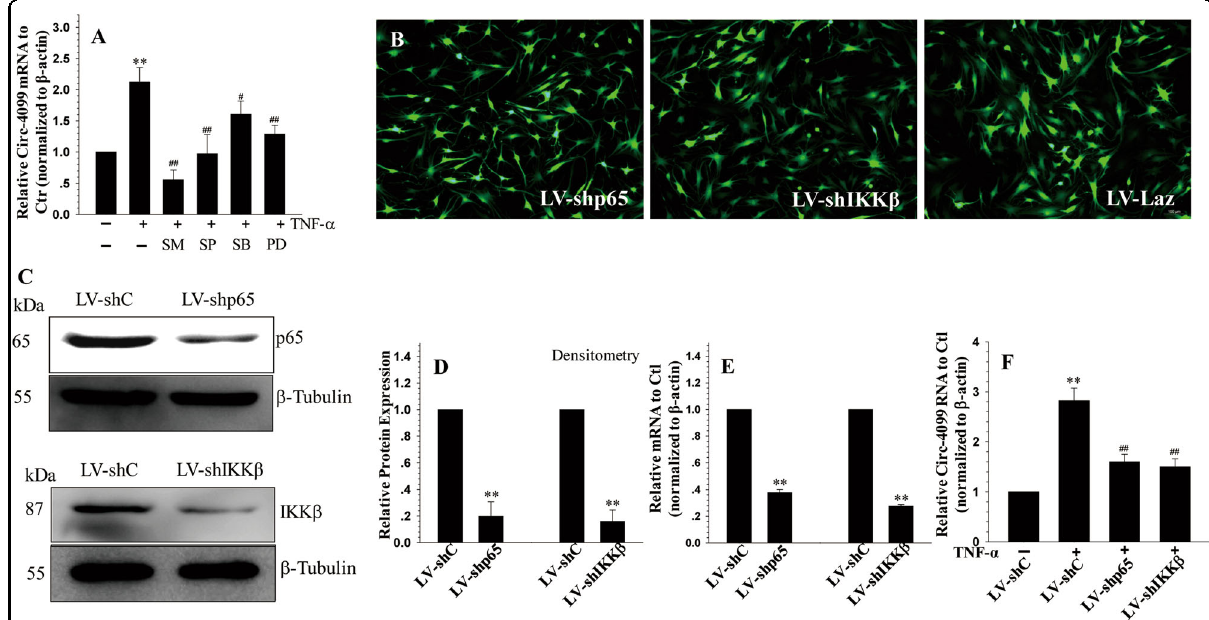
Fig. 2 MAPK and NF- κ B regulation of circ-4099 expression. a qRT-PCR analysis shows that the TNF- α -dependent induction of circ-4099 in NP cells is blocked by MAPK and NF-kB pathway inhibitors. b Immuno fl uorescence detection of GFP in human NP cells transduced with lentivirus (LV) co- expressing GFP and either sh-p65 or sh-Ikk β showed high transduction ef fi ciency. c Western blot, d corresponding densitometry, and e RT-PCR analyses of cells transduced with LV-shLaz, LV-shp65, and LV-shIkk β . Expression of p65 and Ikk β is signi fi cantly blocked by the respective shRNAs compared with the control. f qRT-PCR analysis of circ-4099 expression in cells infected with LV-shC, LV-shp65, and LV-shIkk β following TNF- α treatment. Note that the TNF- α -dependent induction of circ-4099 is signi fi cantly blocked by suppression of NF- κ B pathway